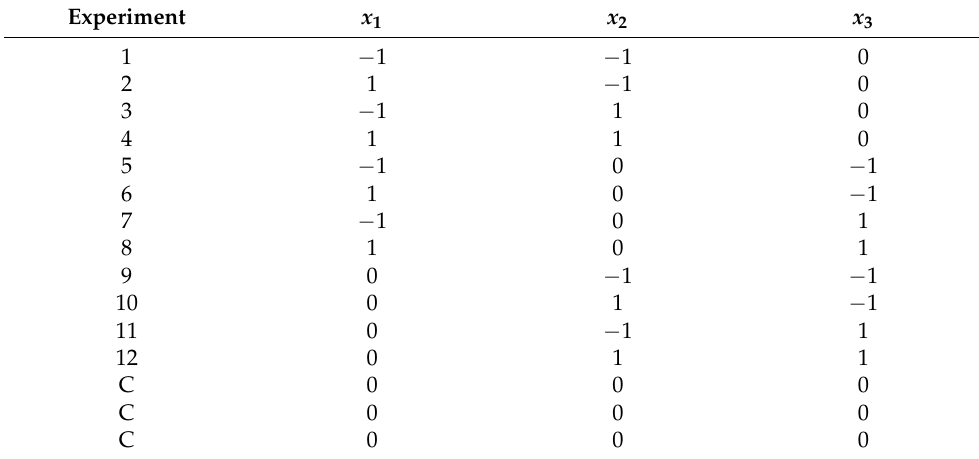
Table 1. Coded factor levels for a Box–Behnken design (BBD) of a three-variable system. Experiment